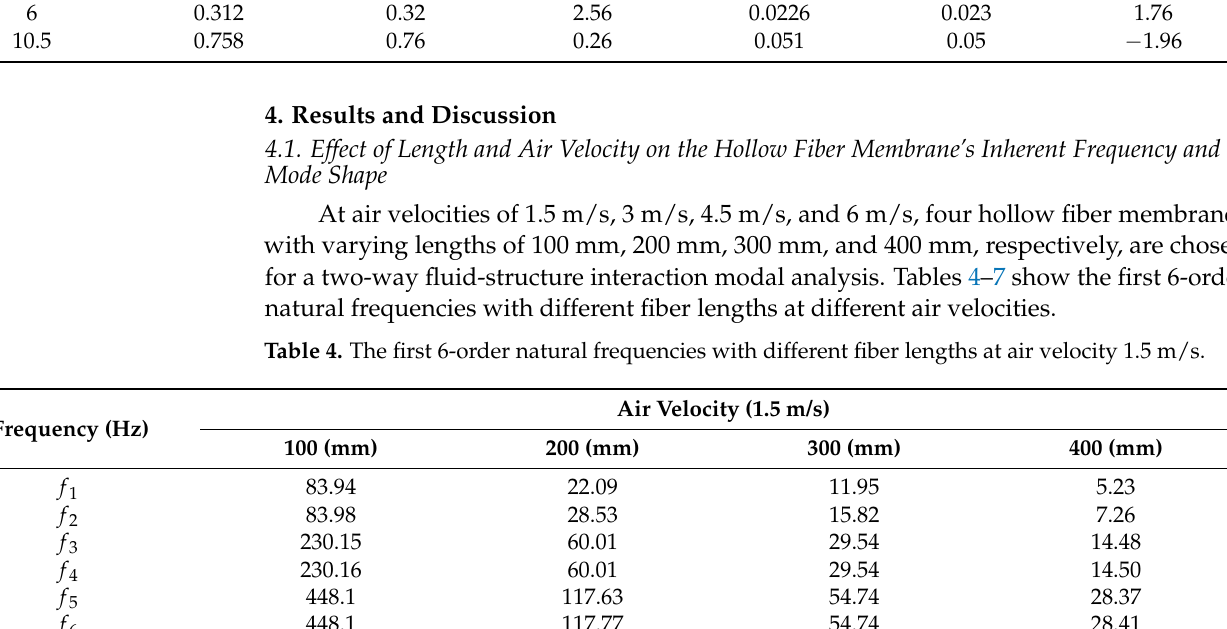
Table 3. Experimental measurements and simulation results of hollow fiber membrane amplitudes in x and y directions at different air velocities.